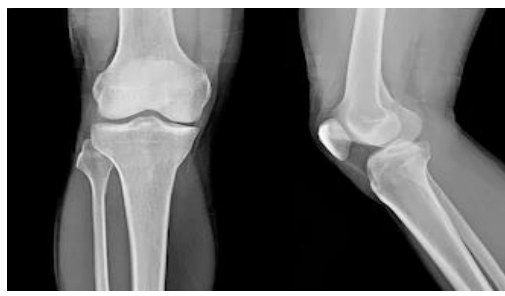
Figure 1: X-Ray of the left knee.